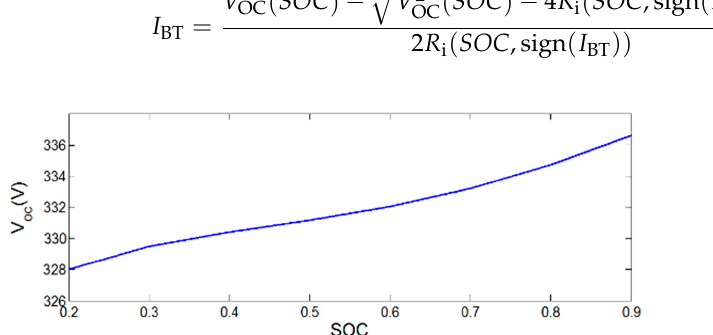
Figure 3. Battery’s open-circuit voltage corresponding to SOC.